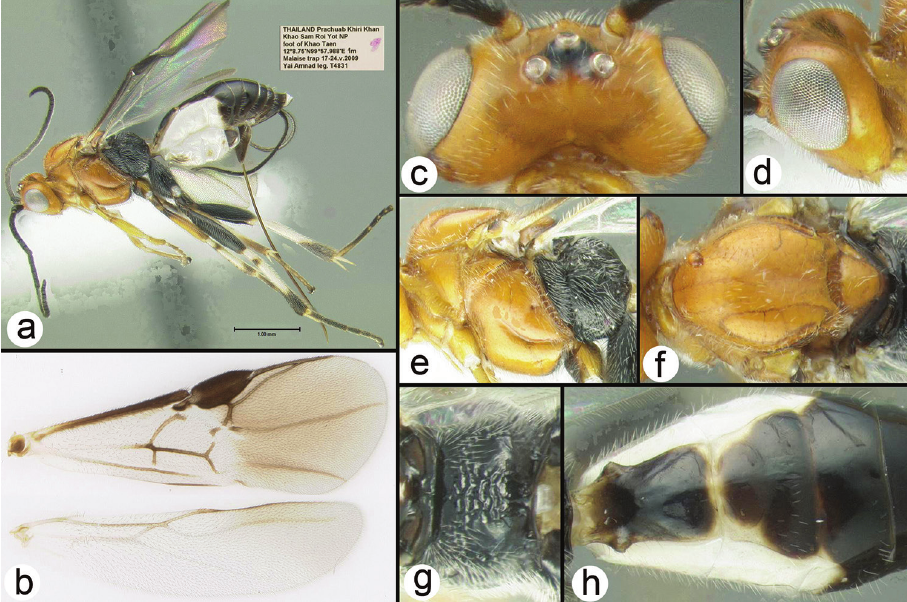
Figure 10. Leuroagathis paulbakeri holotype female: a lateral habitus b wings c dorsal head d lateral head e lateral mesosoma f dorsal thorax g propodeum h metasomal terga